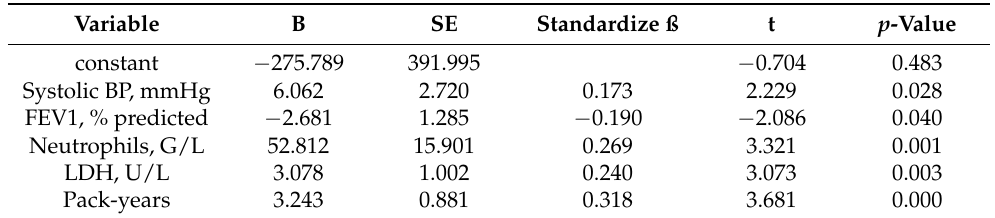
Table 2. Multivariate linear regression analysis with soluble ST2 as dependent variable in the